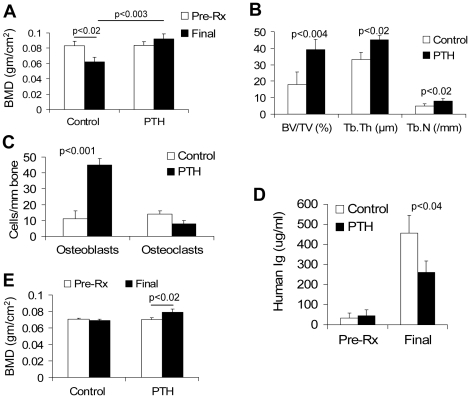
PTH treatment promotes bone formation and attenuates growth of primary myeloma cells in SCID-rab mice.SCID-rab mice were engrafted with primary myeloma cells from 10 patients. In this set of experiments, myeloma cells from the same patient were injected into two mice; one host was treated with saline (Control) and the other with PTH for 4 weeks. A total of 10 hosts were used in each group (see also Table 1). (A) Level of BMD of the implanted bone before initiation of treatment (Pre-Rx) and at experiment's end (Final). (B) Static histomorphometry parameters (BV/TV, Tb.Th, Tb.N) in myelomatous bones from hosts treated with saline (Control) or PTH. (C) Number of osteocalcin-expressing osteoblasts and TRAP-expressing osteoclasts in myelomatous bones from hosts treated with saline (Control) or PTH. (D) Human immunoglobulin (hIg) levels (surrogate for myeloma tumor burden) before initiation of treatment (Pre-Rx) and at experiment's end (Final) in SCID-rab mice engrafted with Hg myeloma cells. (E) Level of BMD of the uninvolved murine femur before initiation of treatment (Pre-Rx) and at experiment's end (Final).